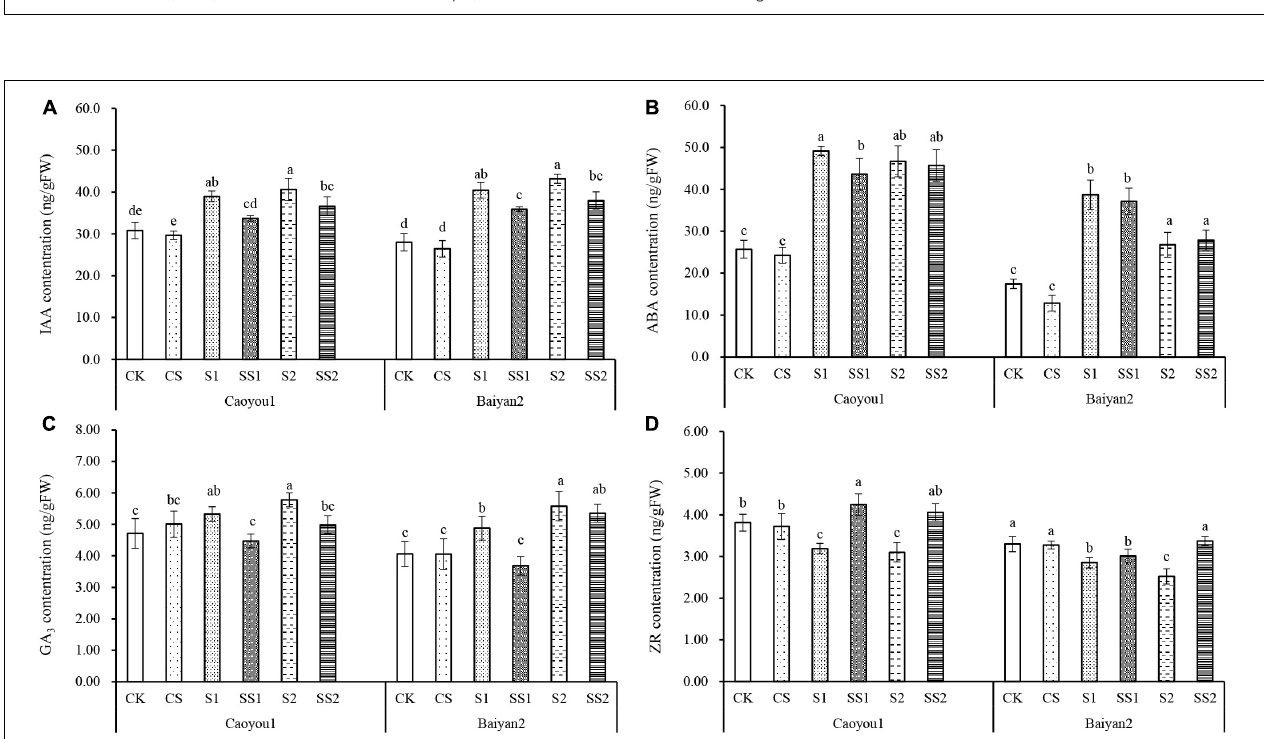
FIGURE 7 | Effects of Spd application on endogenous IAA (A) , ABA (B) , GA 3 (C) , and ZR content (D) under salt stress in the oat seedlings. CK, Nutrient solution + distilled water; CS, Nutrient solution + 0.75 mM Spd; S1, 70 mM salt + distilled water; SS1, 70 mM salt + 0.75 mmol/L Spd; S2, 100 mM salt + distilled water; SS2, 100 mM salt + 0.75 mmol/L Spd; Different lowercase letters indicate significant differences between treatments at 0.05 level.